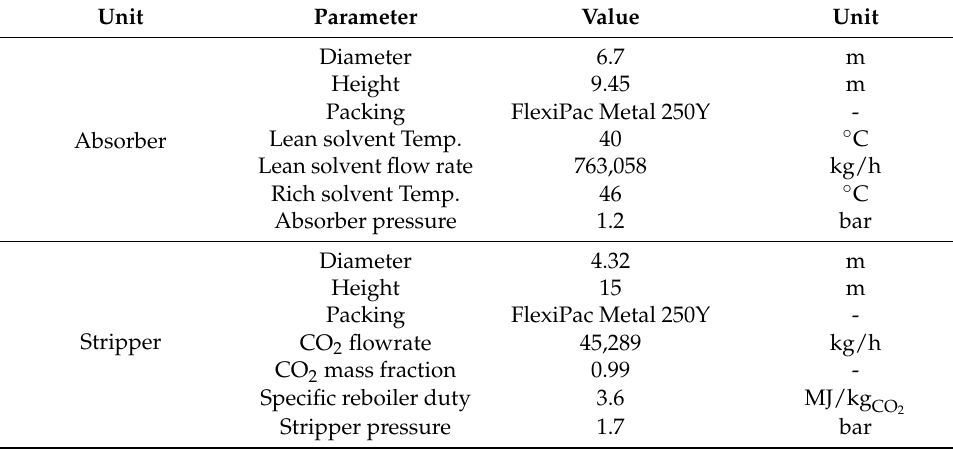
Table 2. Absorber-Stripper design parameters.